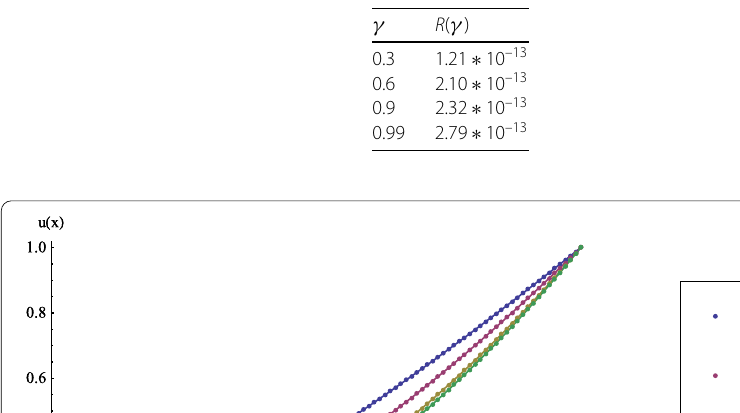
Table 1 Absolute errors